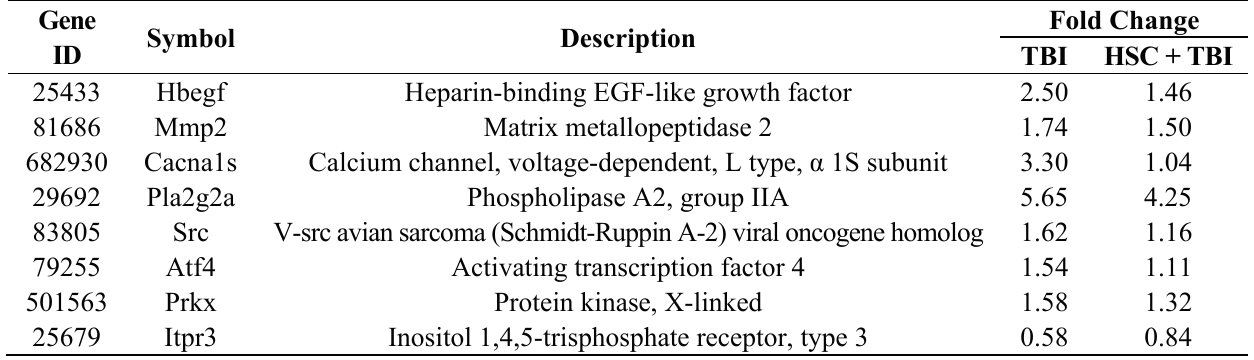
Table 4. The eight genes that were involved in the GnRH signaling pathway.